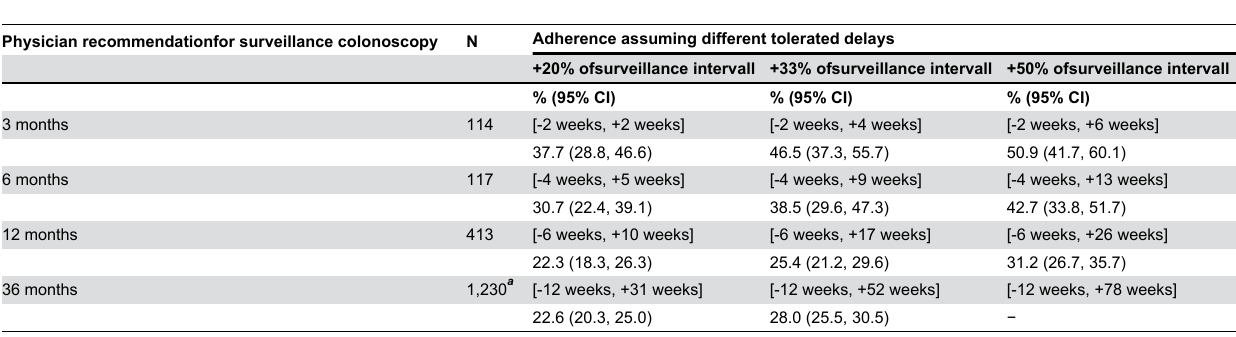
Table 3. Adherence to physician recommendations for surveillance colonoscopy.